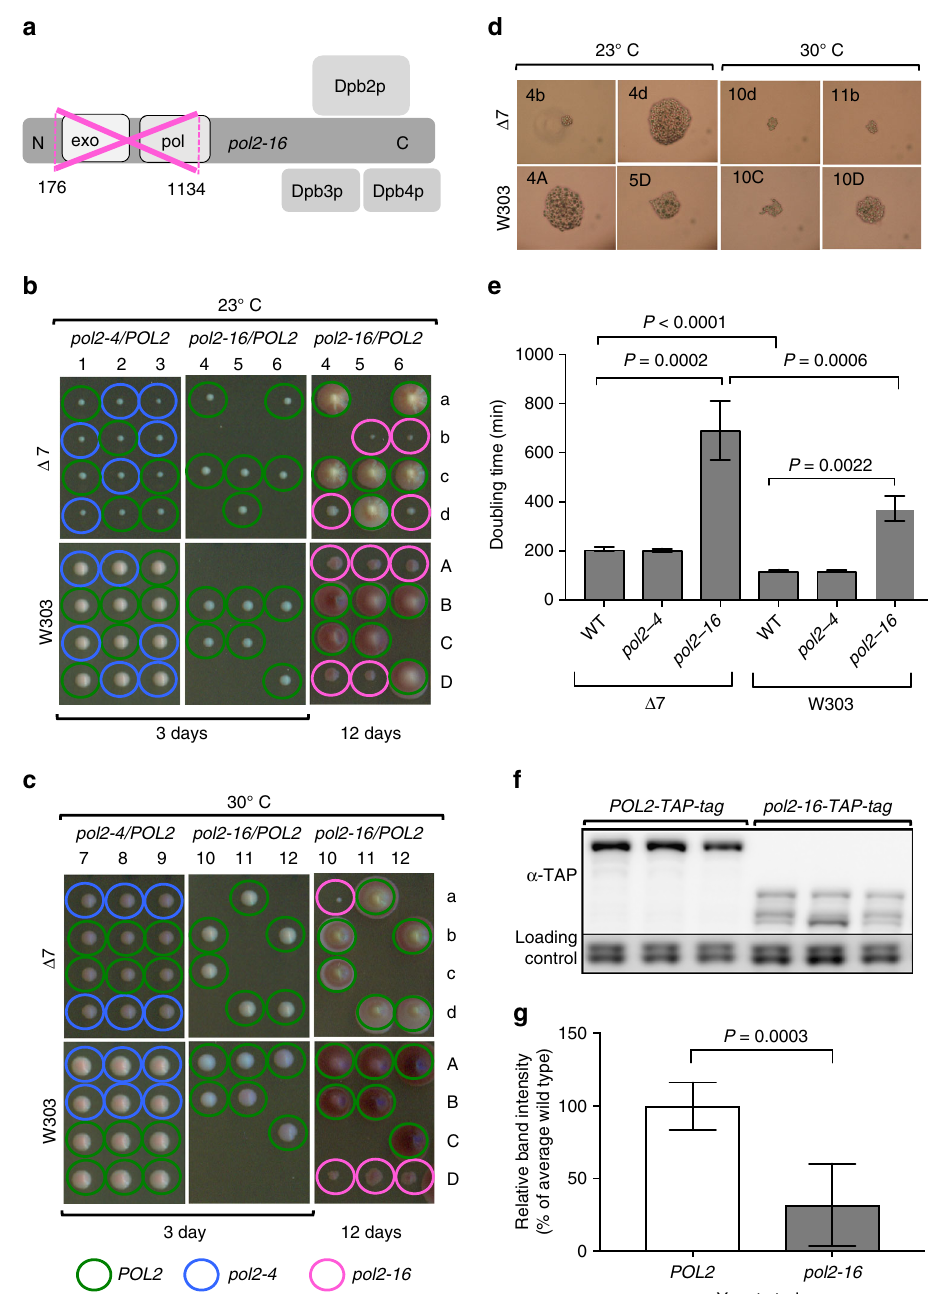
Fig. 1 Pol ε catalytic domains are critical for yeast growth. a Schematic representation of DNA Polymerase ε (Pol ε ). The S. cerevisiae holoenzyme consists of the catalytic subunit (Pol2p) and three auxiliary subunits: Dpb2p, Dpb3p, and Dpb4p 52 – 55 . Cryo-electron microscopy has shown that Pol2p has two lobes tethered by a fl exible linker 43 . Active polymerase and exonuclease domains are in the N-terminal lobe. The pol2-16 mutant has an in-frame deletion of the fragment of catalytically active lobe (amino acids 176 – 1134). b , c Tetrad analysis of pol2-16/POL2 and pol2-4/POL2 heterozygous diploids in two yeast backgrounds, Δ 7, and W303, at 23 °C b and 30 °C c . 1 – 12 are dissected tetrads, A – D, and a – d are haploid spore colonies. Images were taken after 3 and 12 days. Genotypes were con fi rmed via PCR ( pol2-16 , red circles) or sequencing ( pol2-4 , blue). Wild-type colonies are circled in green. The lack of both Pol ε catalytic domains ( pol2-16 ) causes severe growth defects. Exonuclease inactivation alone ( pol2-4 ) does not. d Microscopic images of pol2-16 colonies taken 3 days after tetrad dissections. e Doubling times of pol2-16 and pol2-4 mutants compared to wild-type yeast. Doubling times were estimated